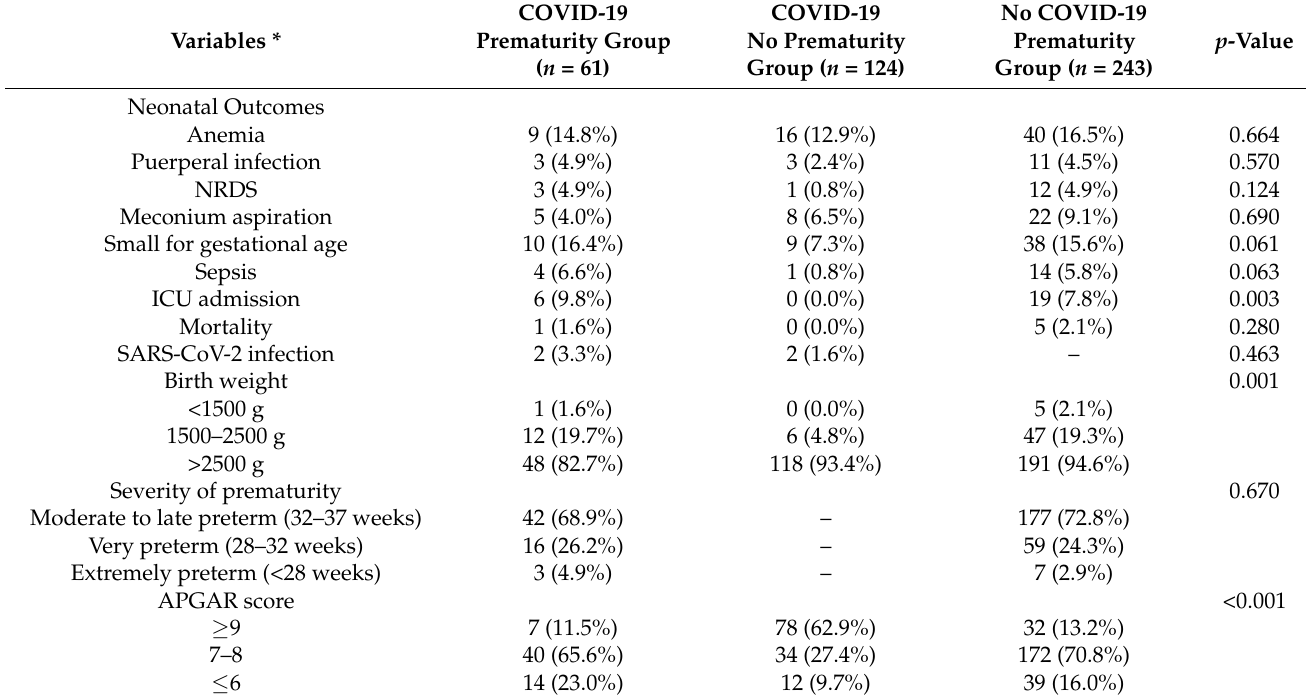
Table 3. Neonatal outcomes.